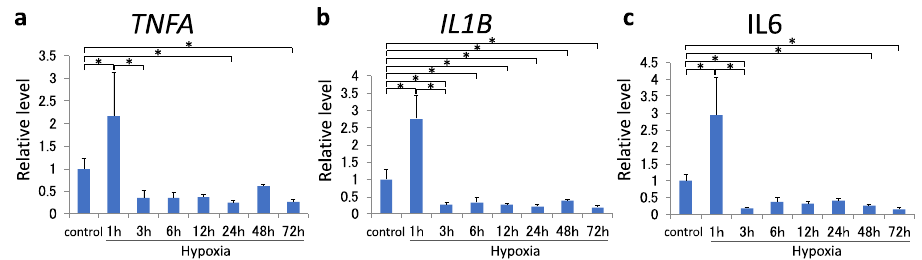
Figure 2. ( a–c ) TNFA ( a ), IL1B ( b ), and IL6 ( c ) mRNA levels in MH7A cells were analyzed using